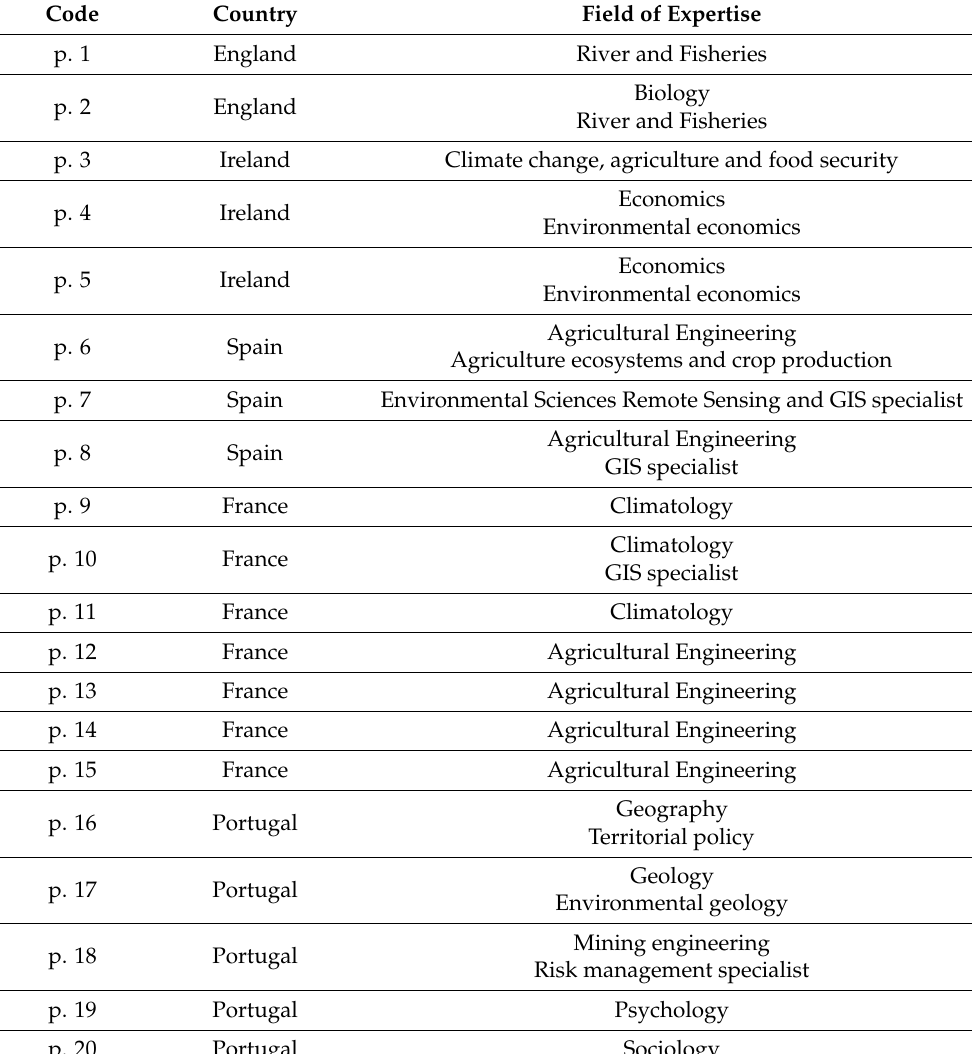
Table 1. Characteristics of